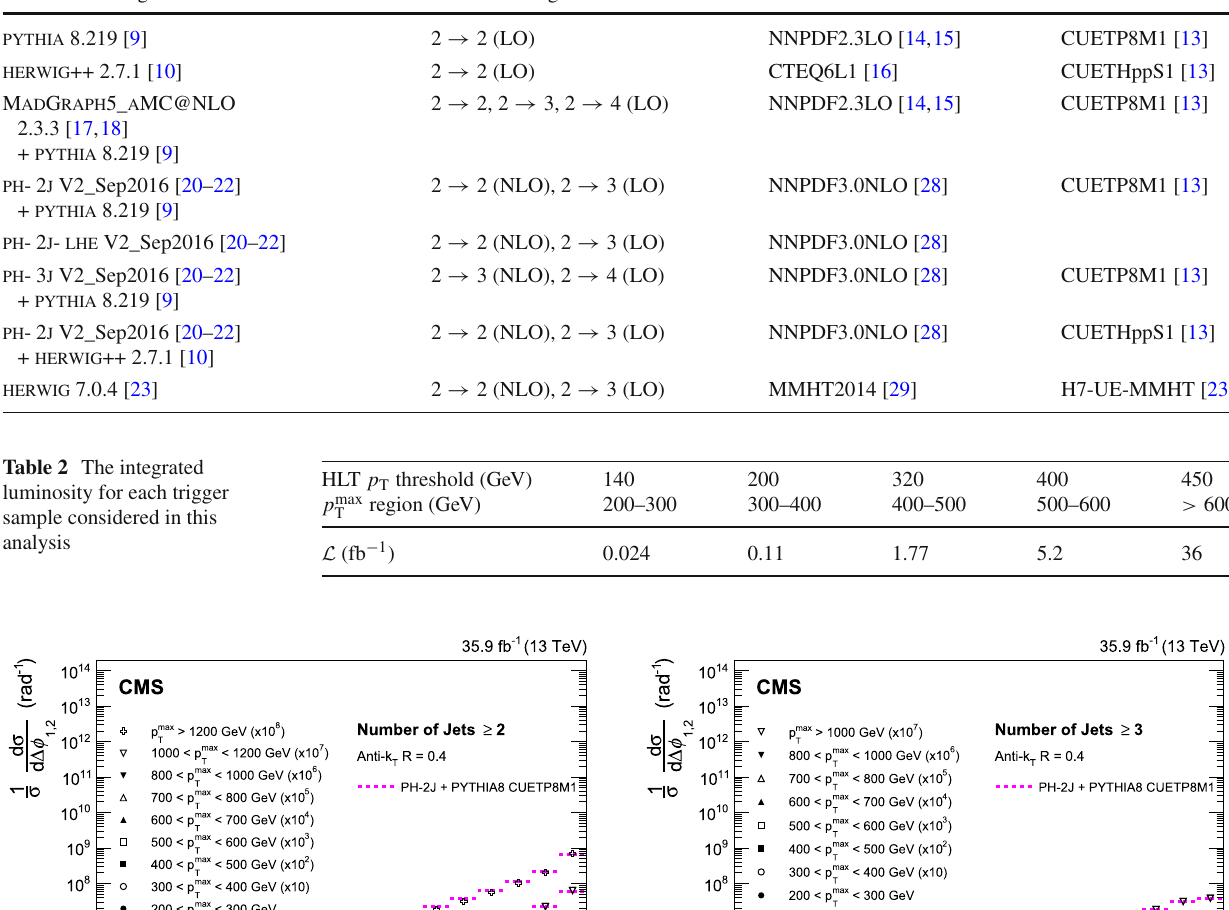
Table 1 Monte Carlo event generators used for comparison in this analysis. Version of the generators, PDF set, underlying event tune, and corresponding references are listed Matrix element generator